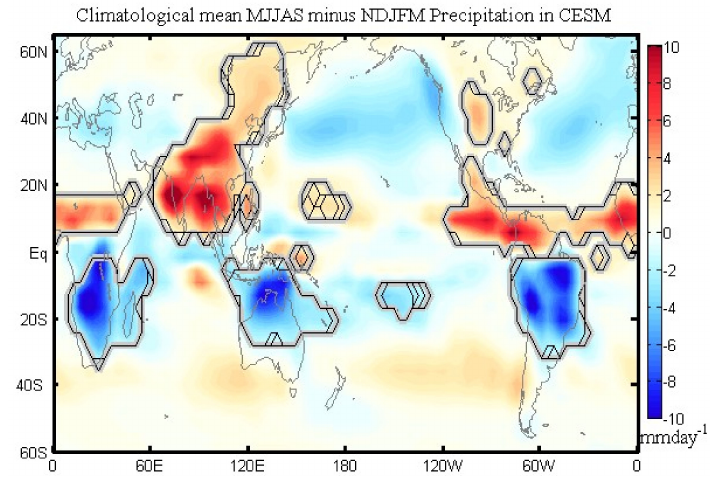
Figure 3. GMP domain and annual reversal of precipitation. Global monsoon domain in different external forcing run during the LIA, PWP (thick black contours) and domain average (bold grey contour). Shading shows the climatological-mean MJJAS-minus-NDJFM precipitation. The GMP domain is defined by local summer-minus-winter precipitation rate exceeding 2.0 mm/d and the local summer precipitation exceeding 55% of the annual